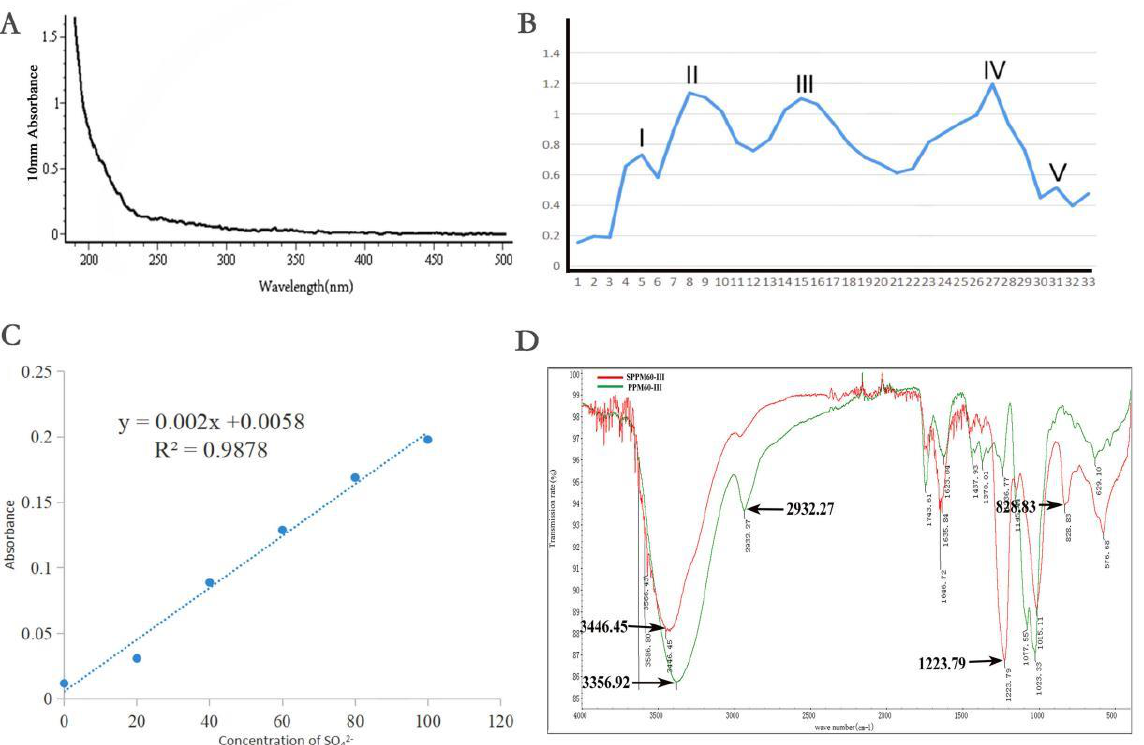
Figure 1. Extraction, separation and sulfation of polysaccharides from pollen of Pinus yunnanensis . ( A ) Ultraviolet spectrum; ( B ) the separation of the curve; ( C ) degree of substitution test; ( D ) infrared spectrum.